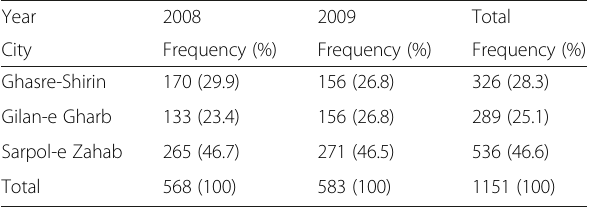
Table 1 The frequency of scorpion stings in the tropical area of